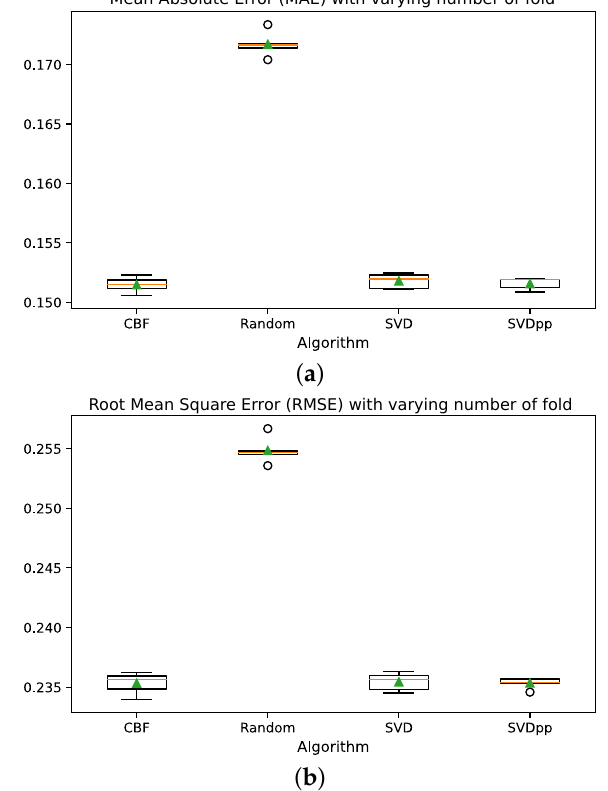
Figure 12. CBF evaluation: ( a ) MAE; ( b )